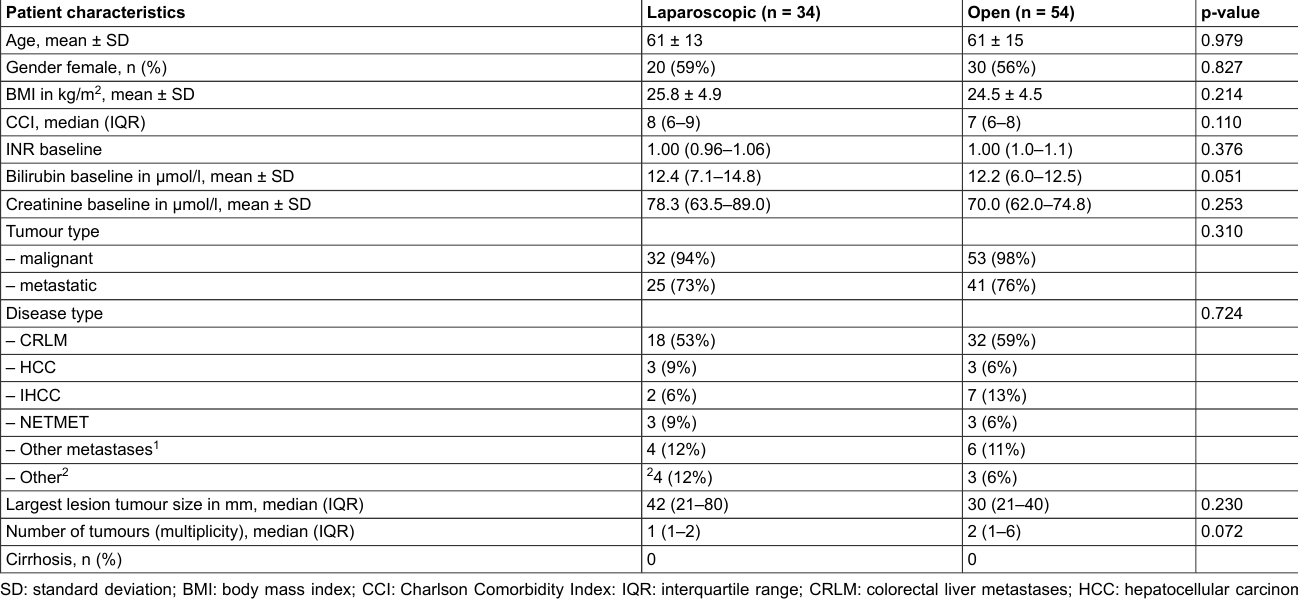
Table 1: Characteristics of patients with major hepatectomy in cantonal hospitals Winterthur and Lugano 2015–2019. Patient